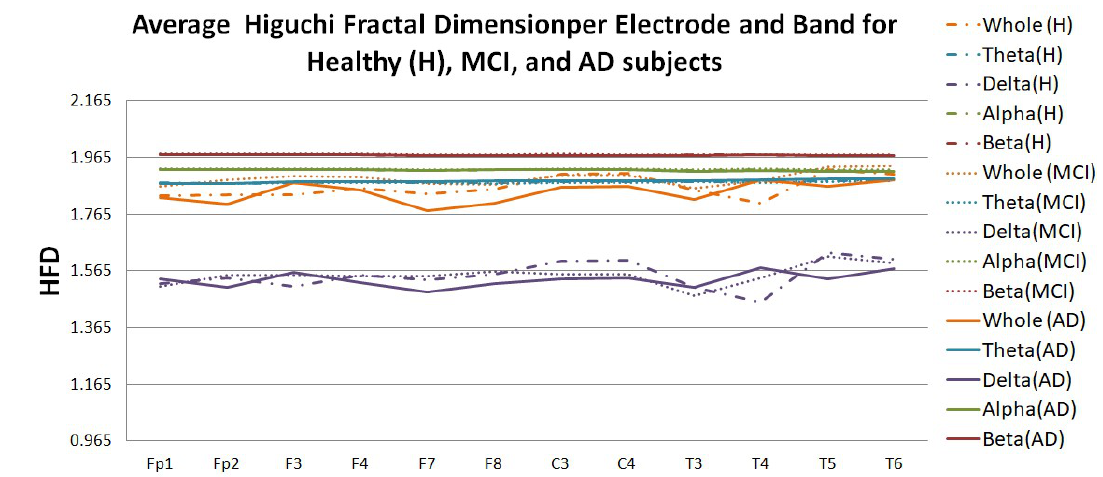
Figure A3: Average Higuchi Fractal Dimension (HFD) per electrode and band for the three sample groups (1’ examined interval – closed eyes).